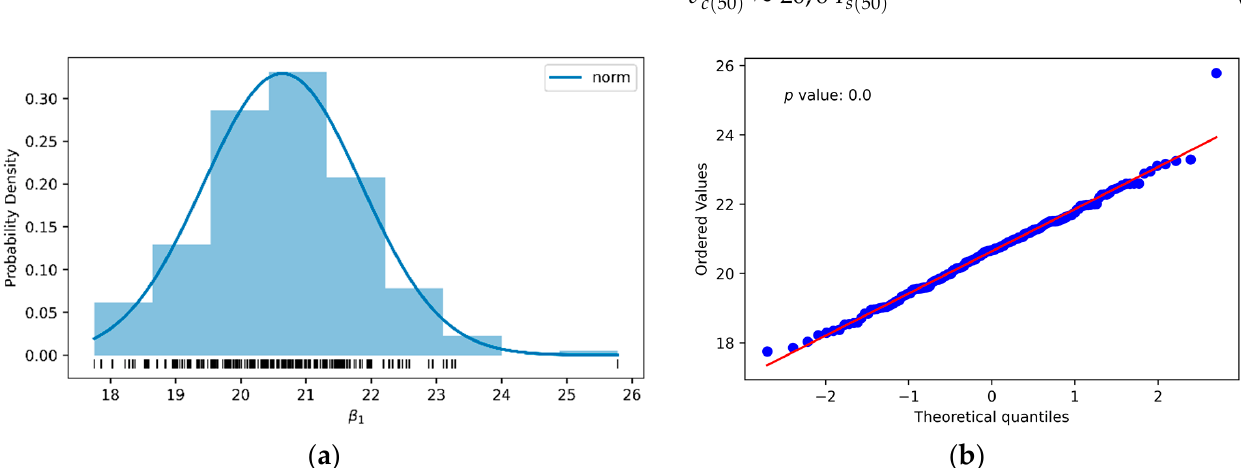
Figure 13. Histogram ( a ) and normal distribution graph ( b ) of the slope β 1 of the linear fit by ordinary least squares of 10 data pairs, of σ c (50) and I s (50) ) of the limestone, randomly selected from 200 random samples. Table 11. Results of the normal distribution of the linear fit for the σ c and I s (50) pairs of the limestone.